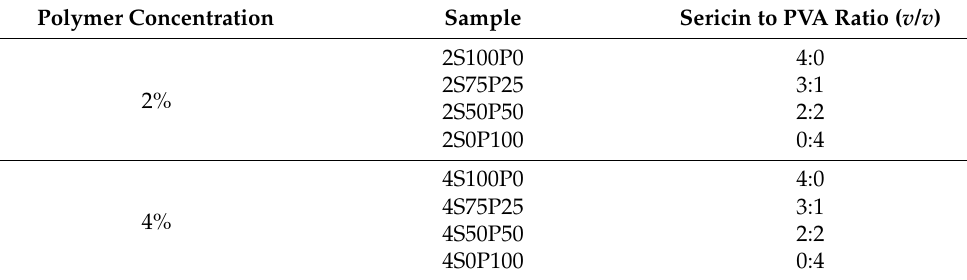
Table 5. Hydrogel